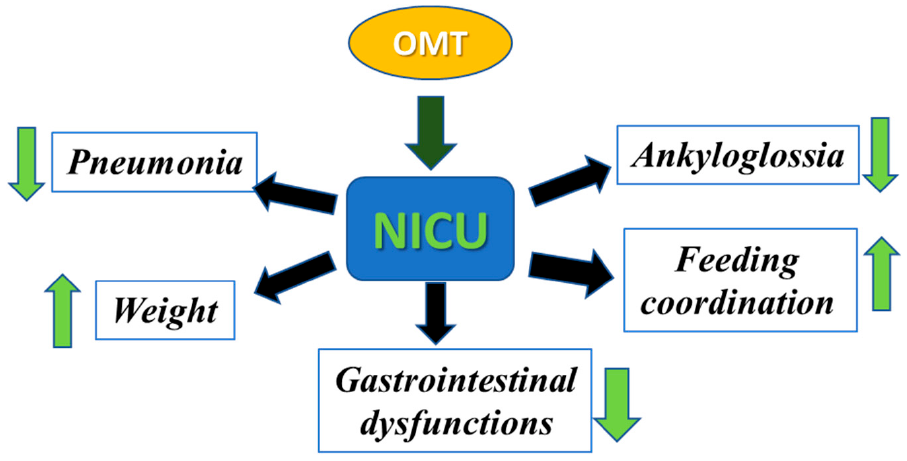
Figure 2. Efficacy of OMT in reducing morbidity and mortality in infants. Different osteopathic techniques can be used to decrease pneumonia, ankyloglossia, and gastrointestinal dysfunction and to increase feeding coordination and weight gain in infants admitted to the NICU.